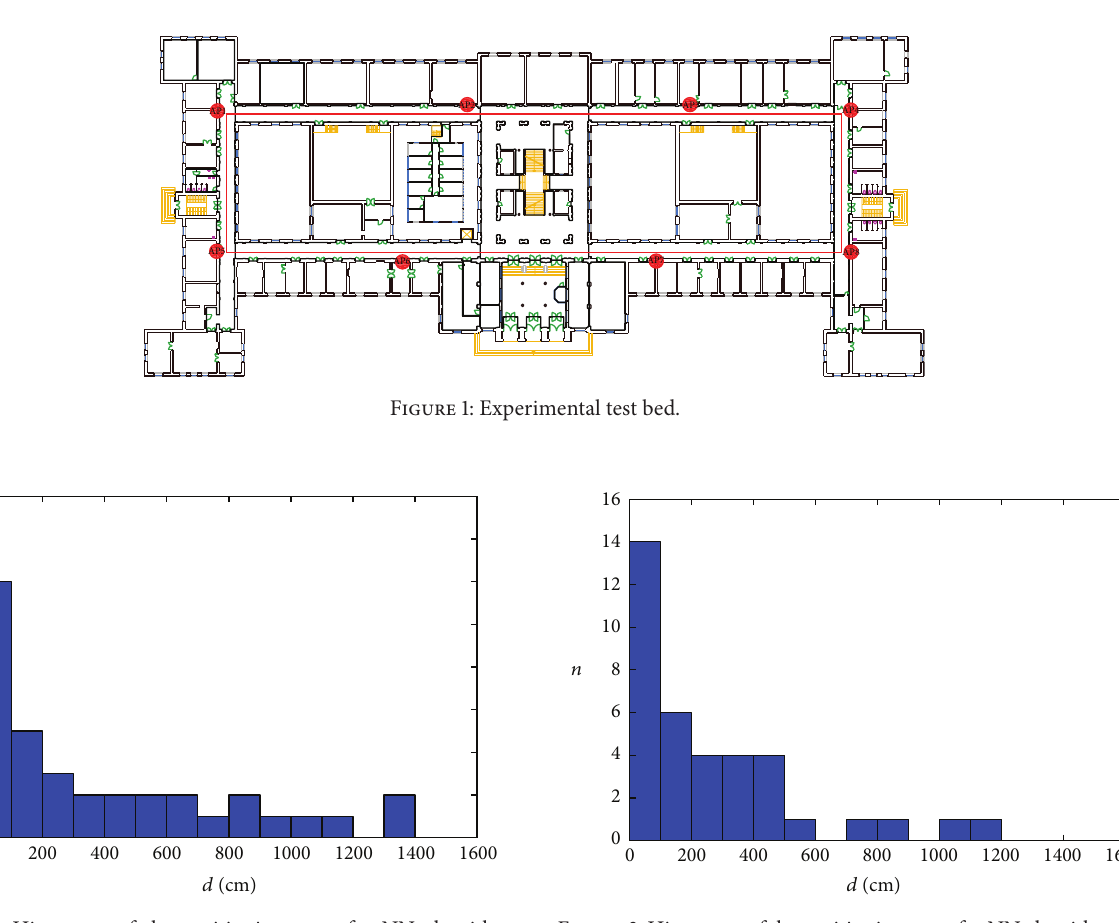
Figure 3: Histogram of the positioning error for NN algorithm with